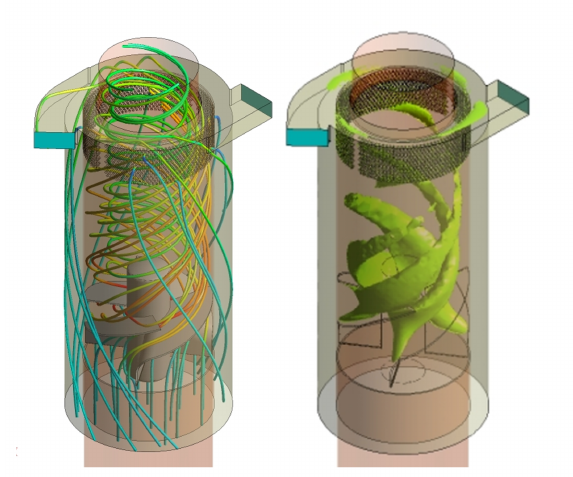
Figure 10. The streamline and velocity isosurface of the moisture